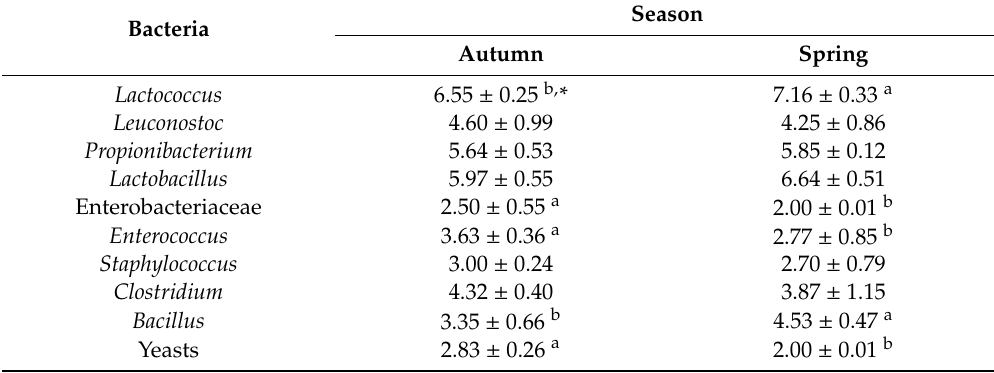
Table 3. Counts of selected microbial groups in Edam cheeses determined by the culture-dependent